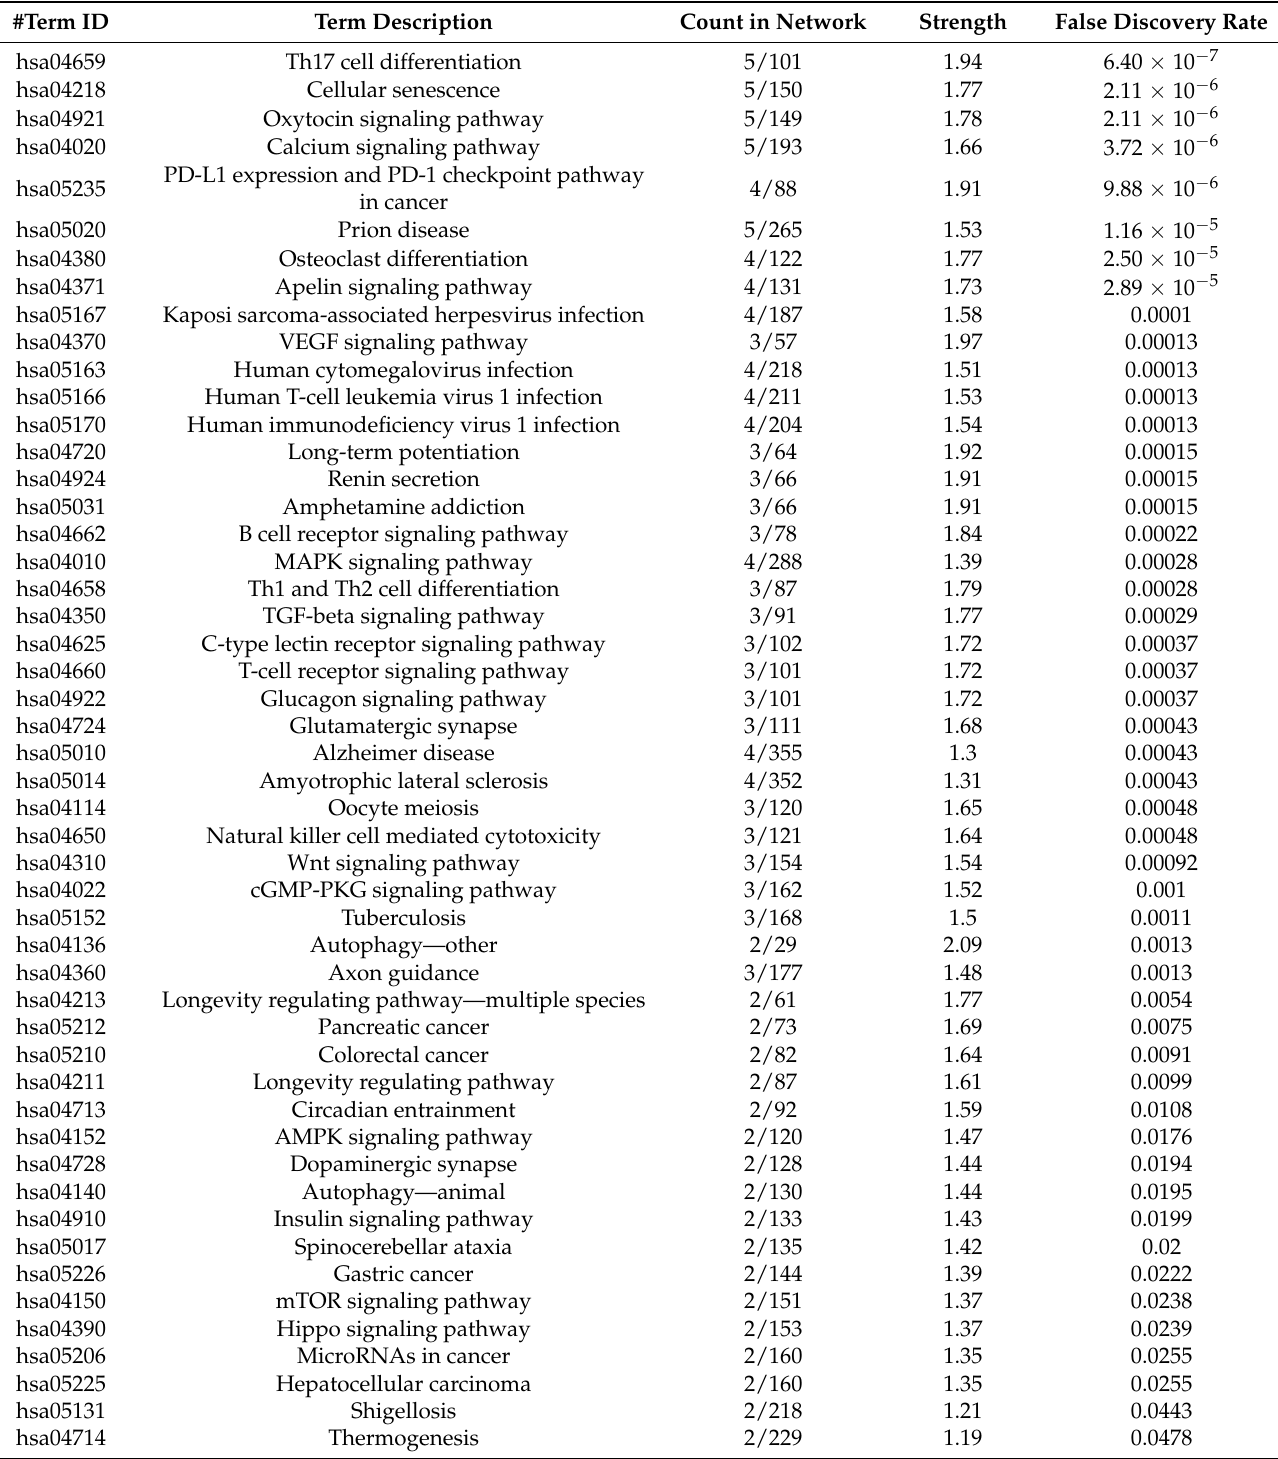
Table 3. LIHC-associated KEGG pathway analysis based on STRING